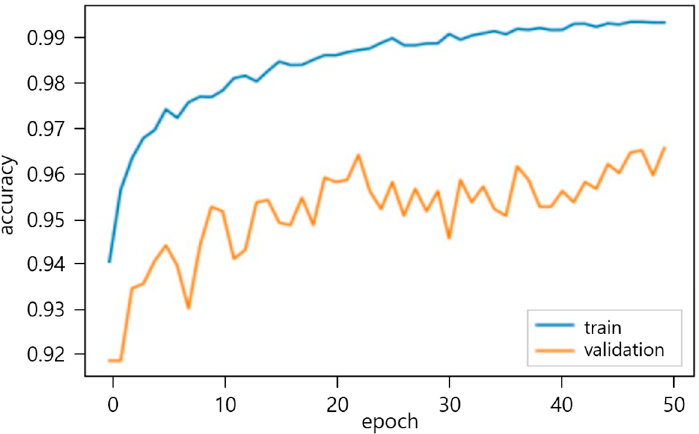
Figure 5. E ffi cientNet-B7 model classi fi cation accuracy.